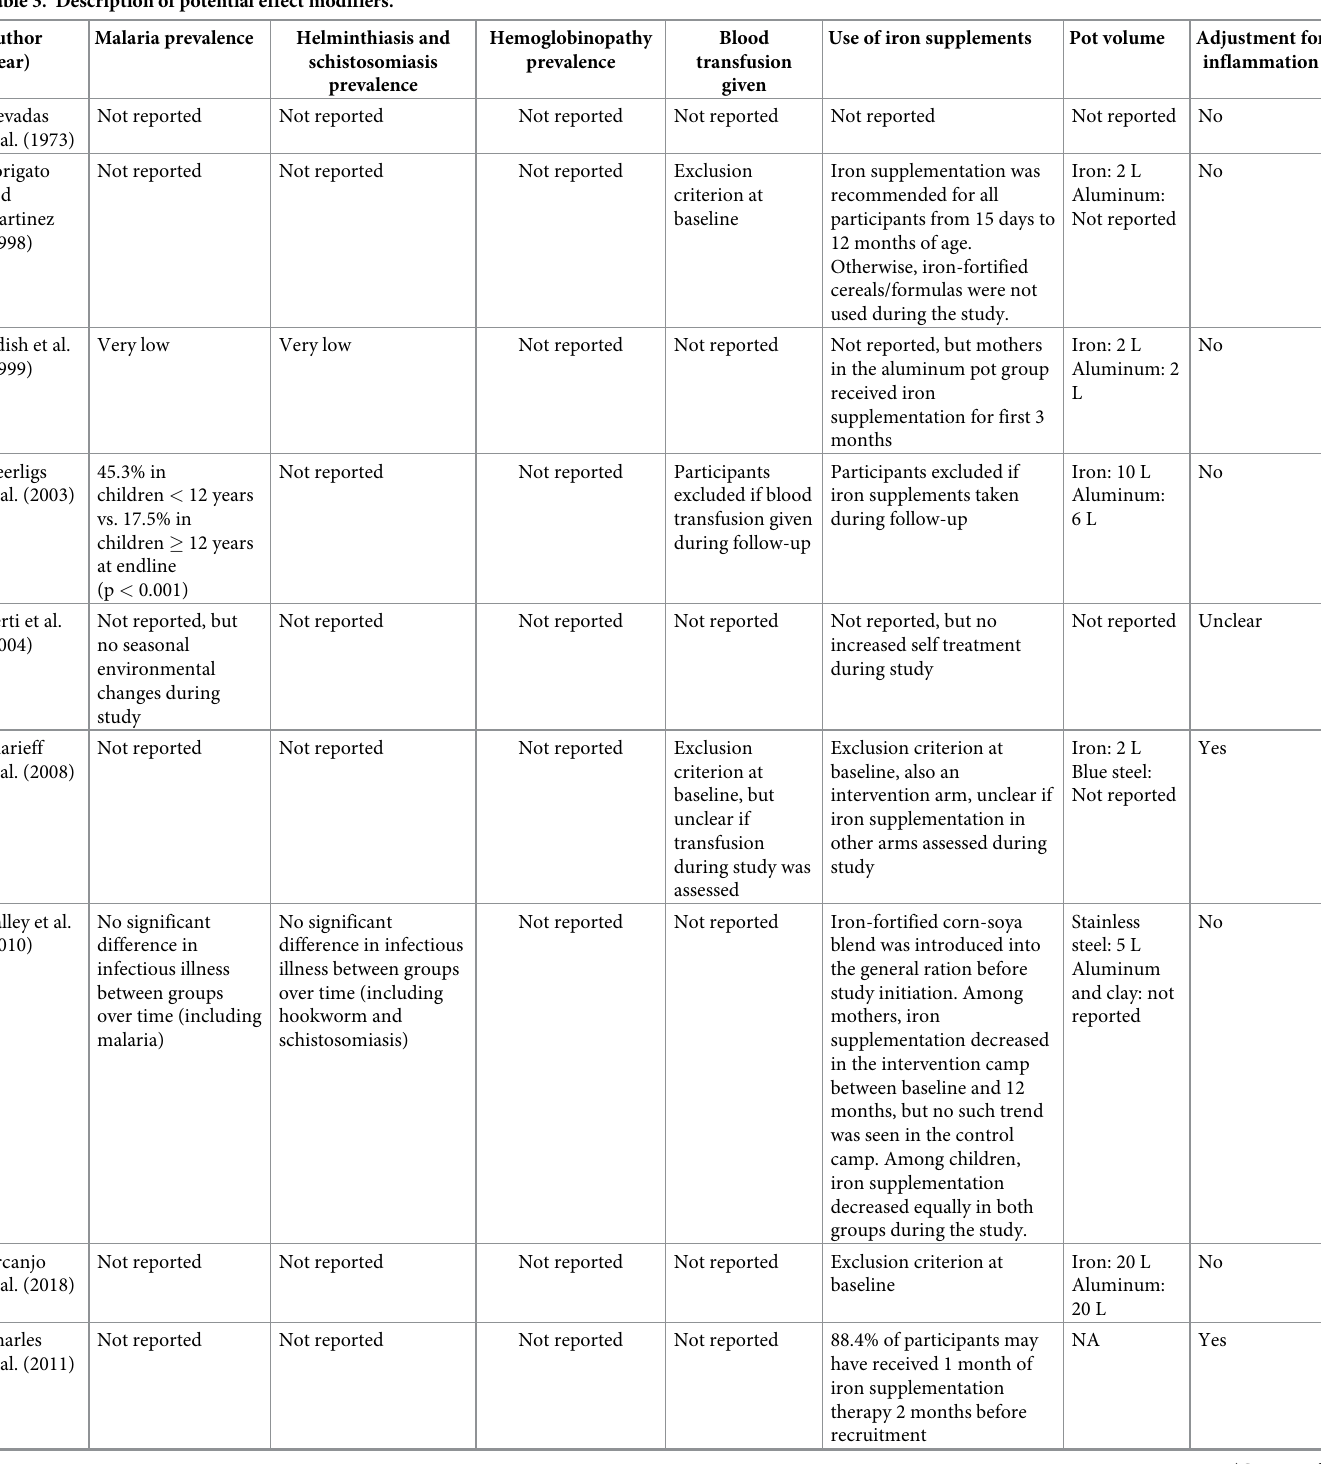
Table 3. Description of potential effect